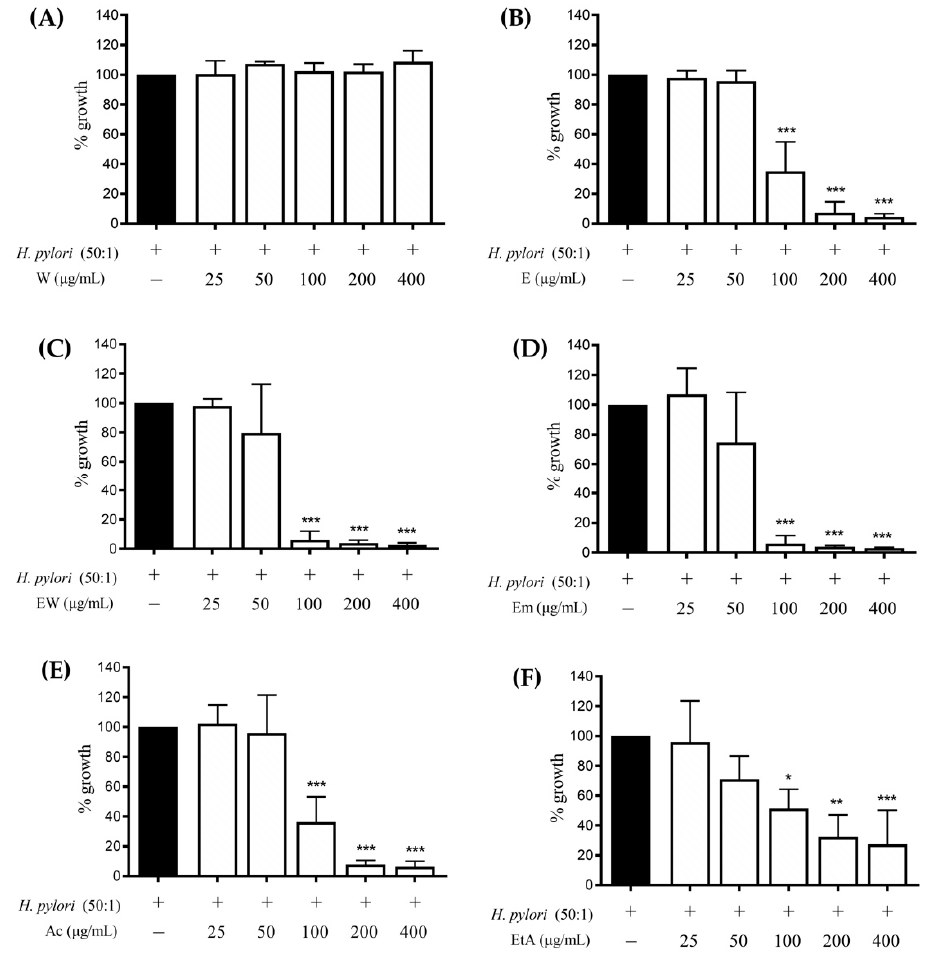
Figure 4. Effect of Rhus coriaria L. extracts (( A ) 100% water (W), ( B ) 100% ethanol (E), ( C ) ethanol– water (ethanol:water 50:50 v / v , EW), ( D ) ethanol macerated (plant material subjected to maceration with pure ethanol for 48 h, Em), ( E ) acetone (Ac), ( F ) ethylacetate (EtA)) on H. pylori growth. Data are expressed in terms of growth inhibition of the bacterium compared to the control with only H. pylori (incubation time: 72 h), which was arbitrarily assigned value of 100%. The reference antibiotic (black color) used was tetracycline 0.125 µ g/mL (100% inhibition). * p < 0.05; ** p < 0.01; *** p < 0.001 versus H. pylori .